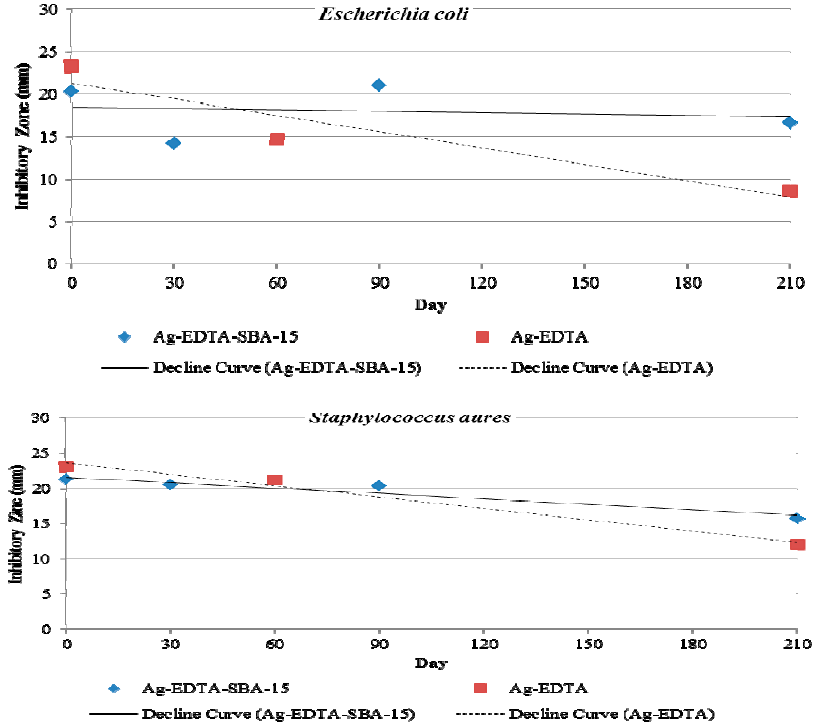
Figure 8. Inhibition zones of Ag-EDTA-SBA-15 and Ag-EDTA against Escherichia coli ( top ) and Staphylococcus aureus ( bottom ) after storage time of 0, 30, 60, 90, and 210 d.